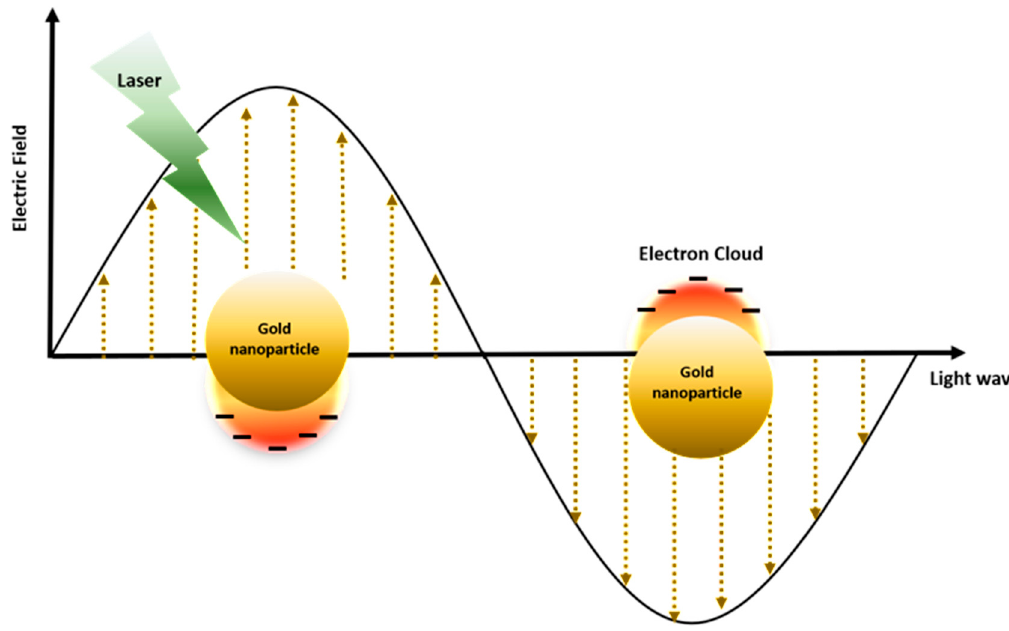
Figure 2. The localized surface plasmon resonance (LSPR) phenomenon on the surface of gold nanoparticles under irradiation at specific light wavelengths.